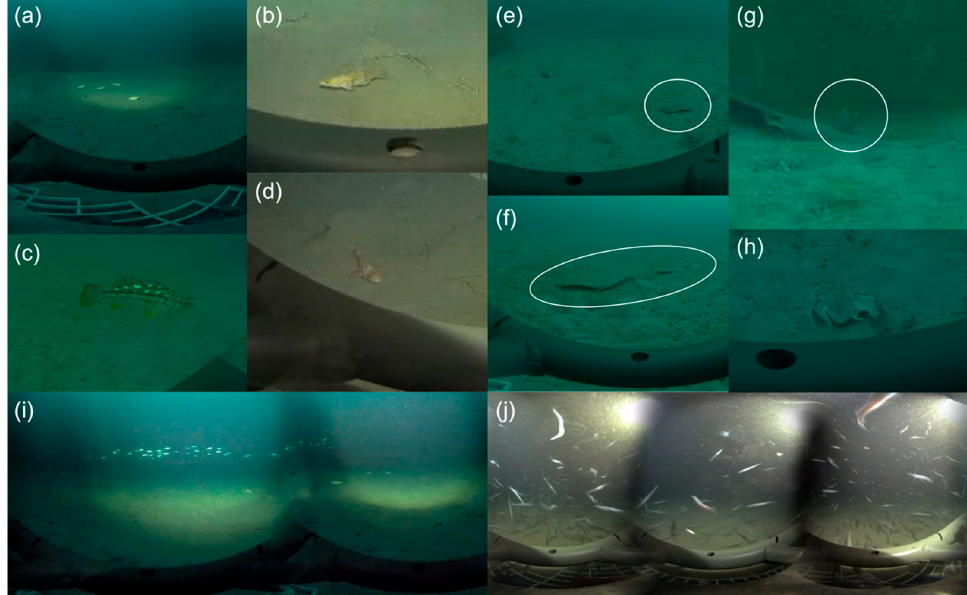
Figure 7 . Screenshots of fish and mega-invertebrates observed on the video footage from La Jolla, CA: ( a , b ) sand bass; ( c ) kelp bass; ( d ) California scorpionfish; ( e , f ) flatfish, circled in white; ( g ) Unidentified invertebrate, circled in white; ( h ) octopus; and ( i , j ) bait fish schools.